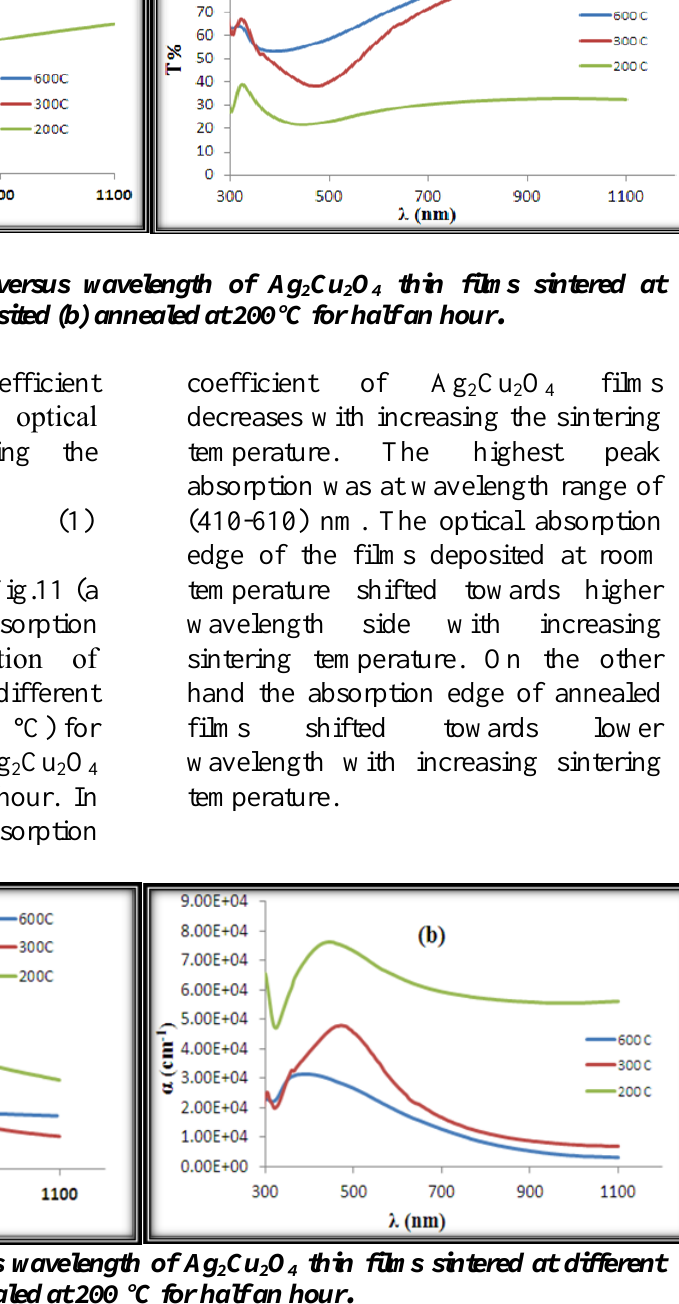
Cu O thin films sintered at different 2 2 4